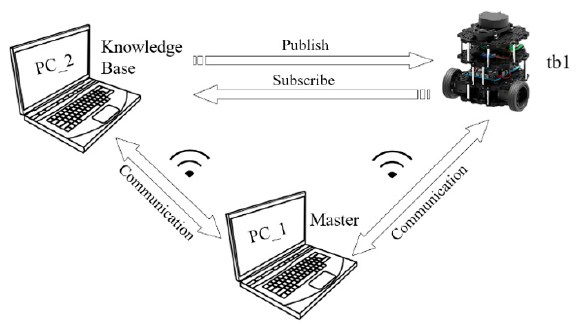
Figure 17. The communication among different devices.